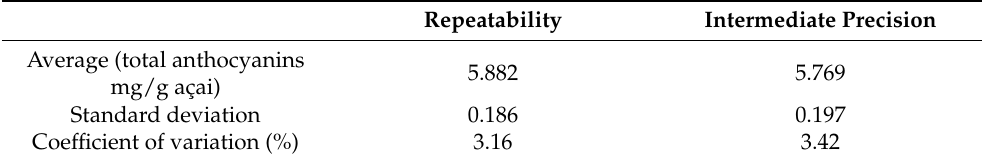
Table 4. Repeatability ( n = 12) and intermediate precision ( n = 6 + 6 + 6) of the optimized